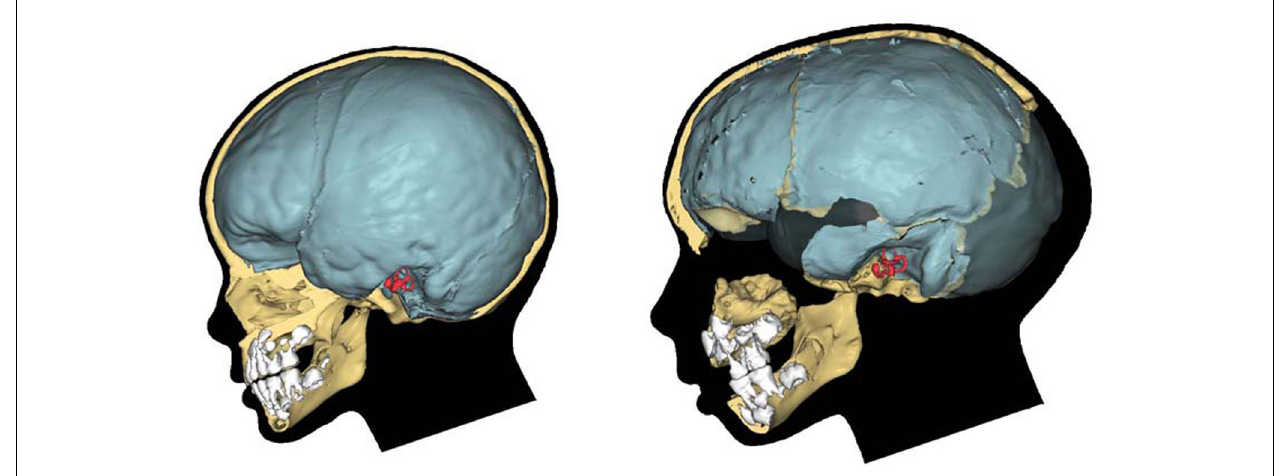
FIGURE 2 | Early brain shape comparison. A modern human child (left) and the Gibraltar 1 Neanderthal (right; reproduced from http://www.aim.uzh.ch/ morpho/wiki/CAP/N2).